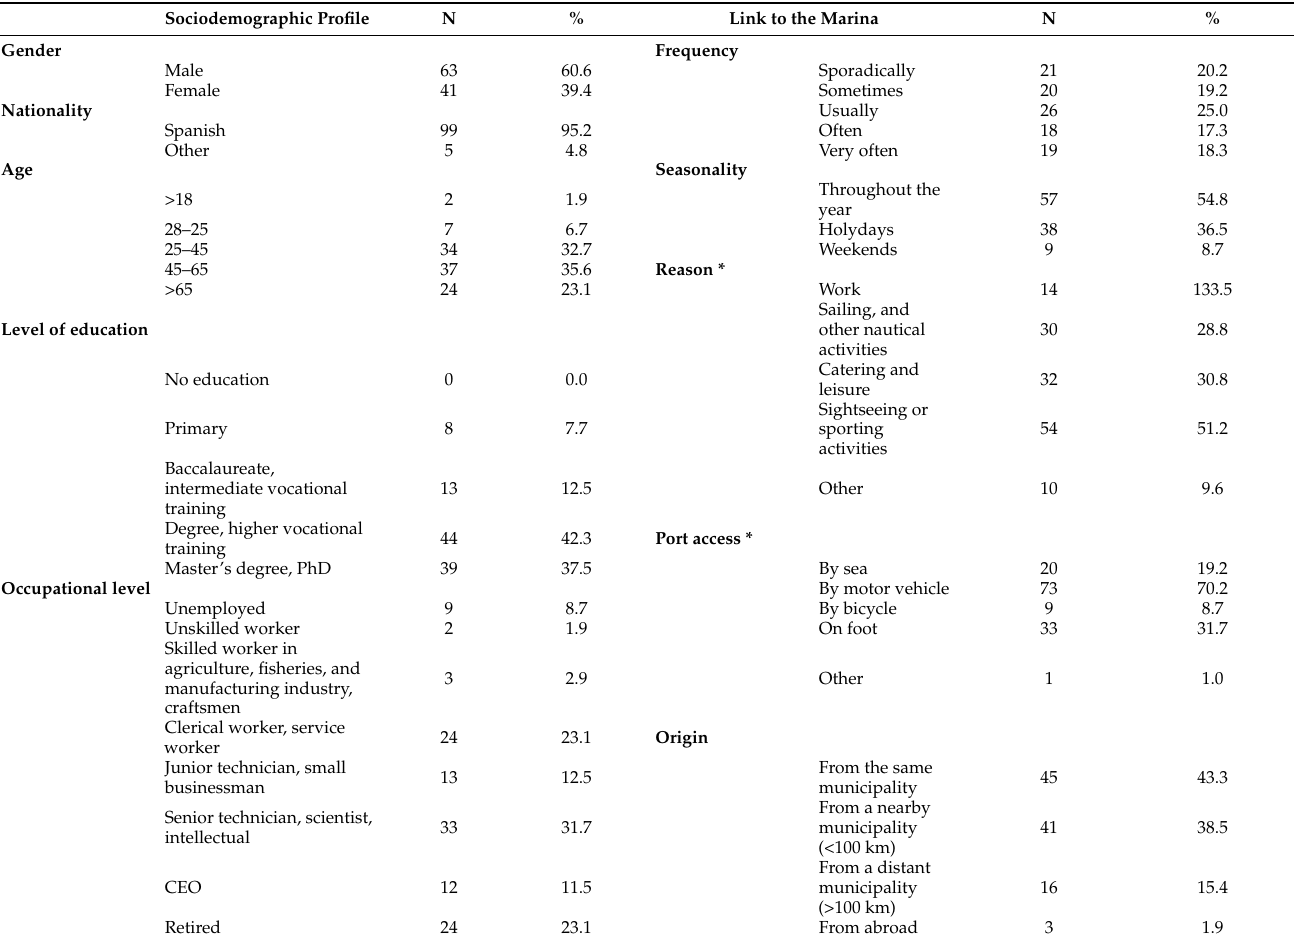
Table 3. Characterization of the sample size (N =